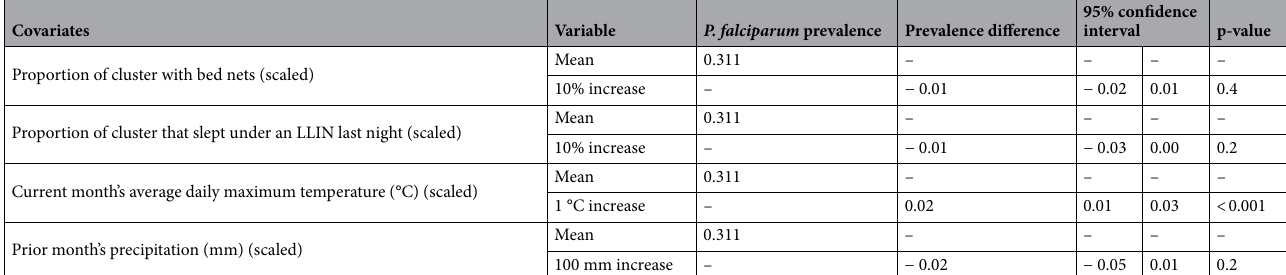
Table 2. Bivariate associations between demographic and environmental risk factors and P. falciparum prevalence using weighted survey data. LLIN long-lasting insecticide treated net.